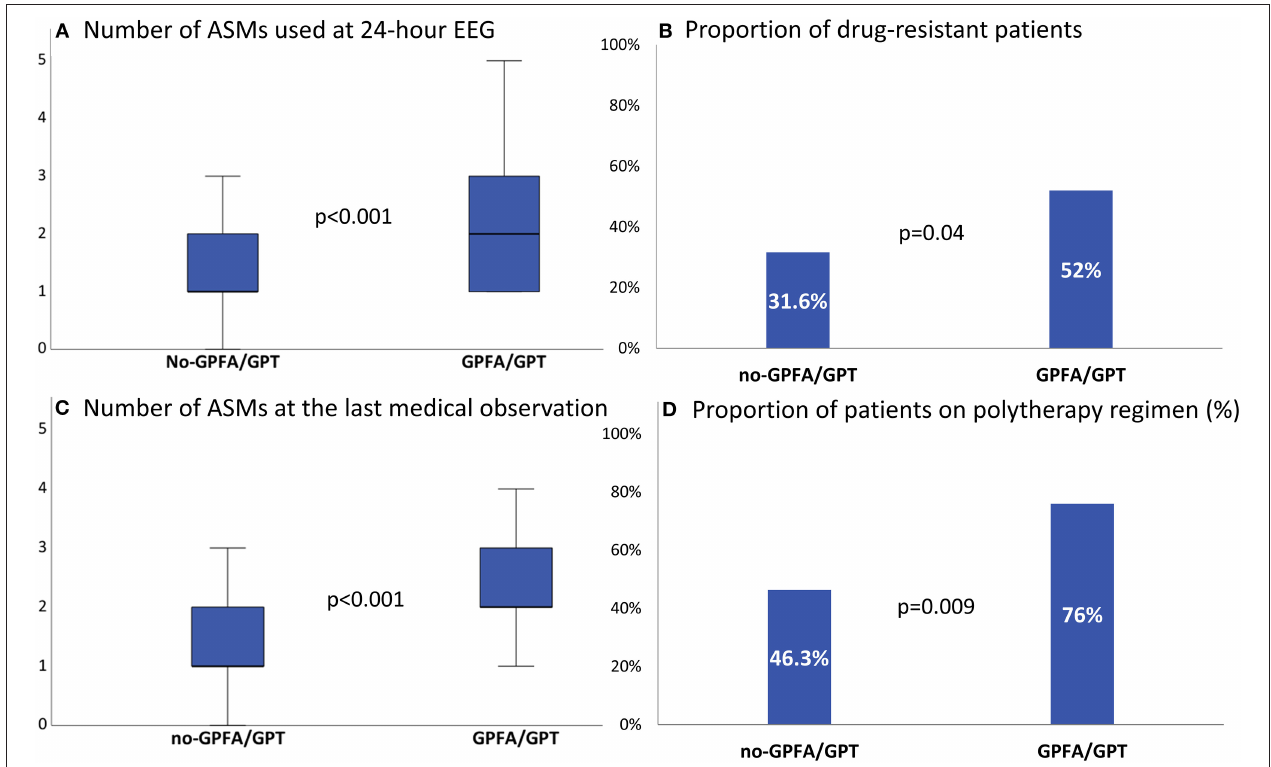
FIGURE 3 | Antiseizure medication burden at different timepoints according to the presence or absence of generalized fast discharges. (A,C) Whisker plots representing the median number of antiseizure medications at different time points. (B,D) Bar graph showing the proportion of patients with drug-resistance and with a polytherapy regimen at the last medical observation. ASM, antiseizure medication; GPFA, generalized paroxysmal fast activity; GPT, generalized polyspike